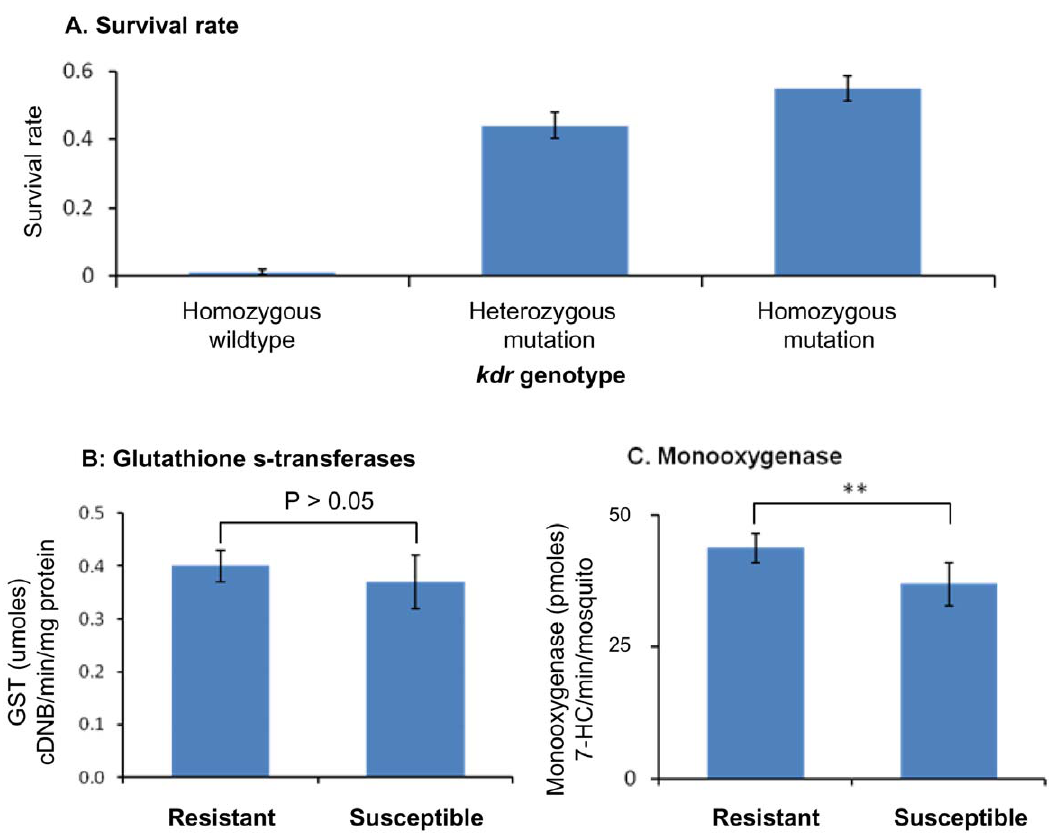
Figure 5. Relationship between kdr , metabolic detoxifying enzyme activity and pyrethroid resistance in Anopheles sinensis. Association between kdr genotypes and survival rate of mosquitoes after the standard WHO tube deltamethrin susceptibility bioassay ( A ), and variation of resistant (survived the bioassay) and susceptible (died in the bioassay) individuals in glutathione s-transferases activity ( B ) and monooxygenases activity ( C ). **, P , 0.01.